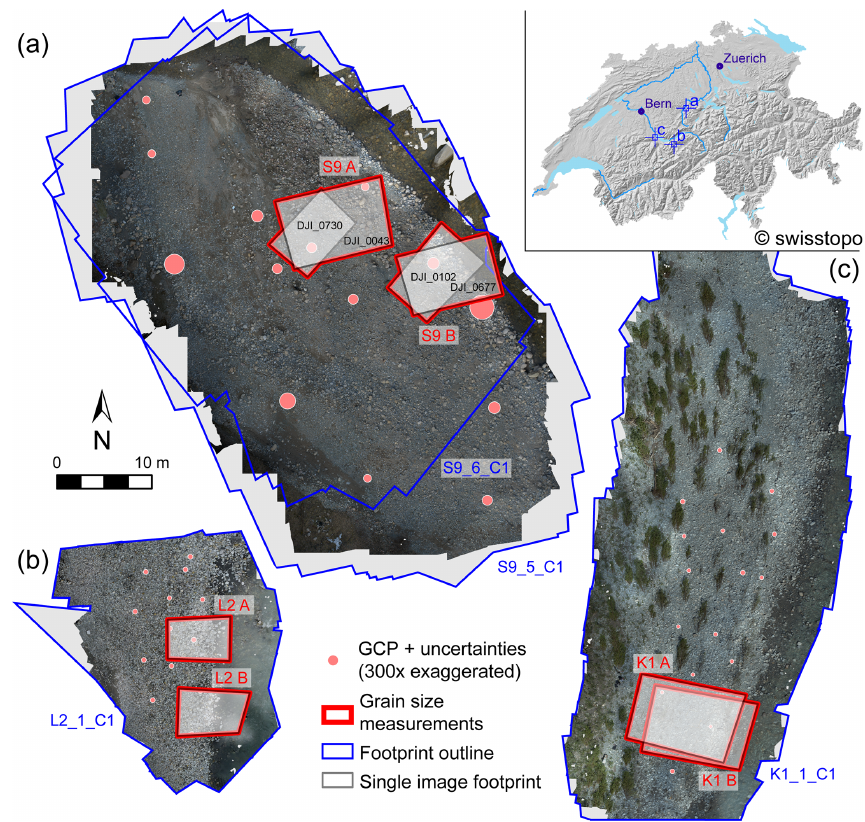
Figure 1. Overview of the surveyed gravel bars along the selected Swiss rivers (see insert) as overview orthophoto mosaic from the most accurate topographic models (see text for discussion): (a) Entle surveys (S9_5, S9_6), (b) Luetschine survey (L2), and (c) Kander survey (K1). Regions A and B, which are used for grain size measurements (both orthophoto mosaic and single, undistorted nadir image) are indicated. GCP: ground control